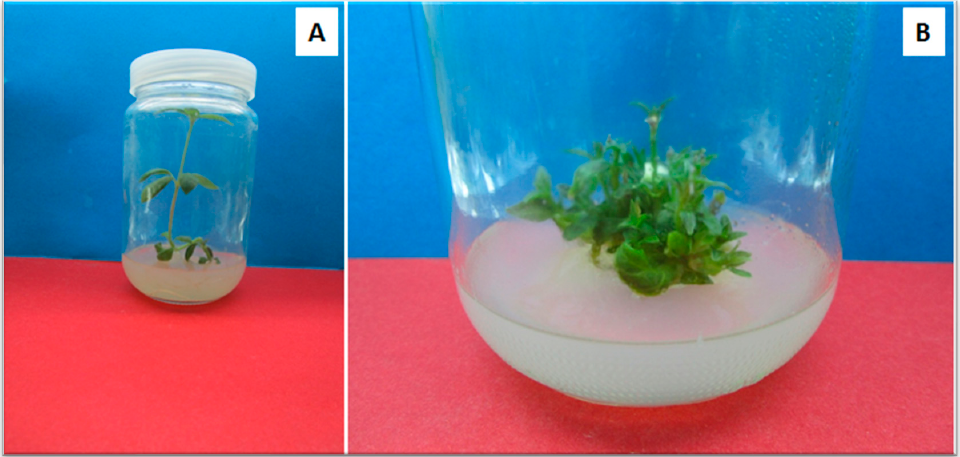
Figure 8. Rosette phenomenon (recalcitrant to elongation) of in vitro Jerusalem artichoke plant ( Helianthus tuberosus L.). Photo ( A ) = normal elongated shootlet, whereas photo ( B ) = rosette